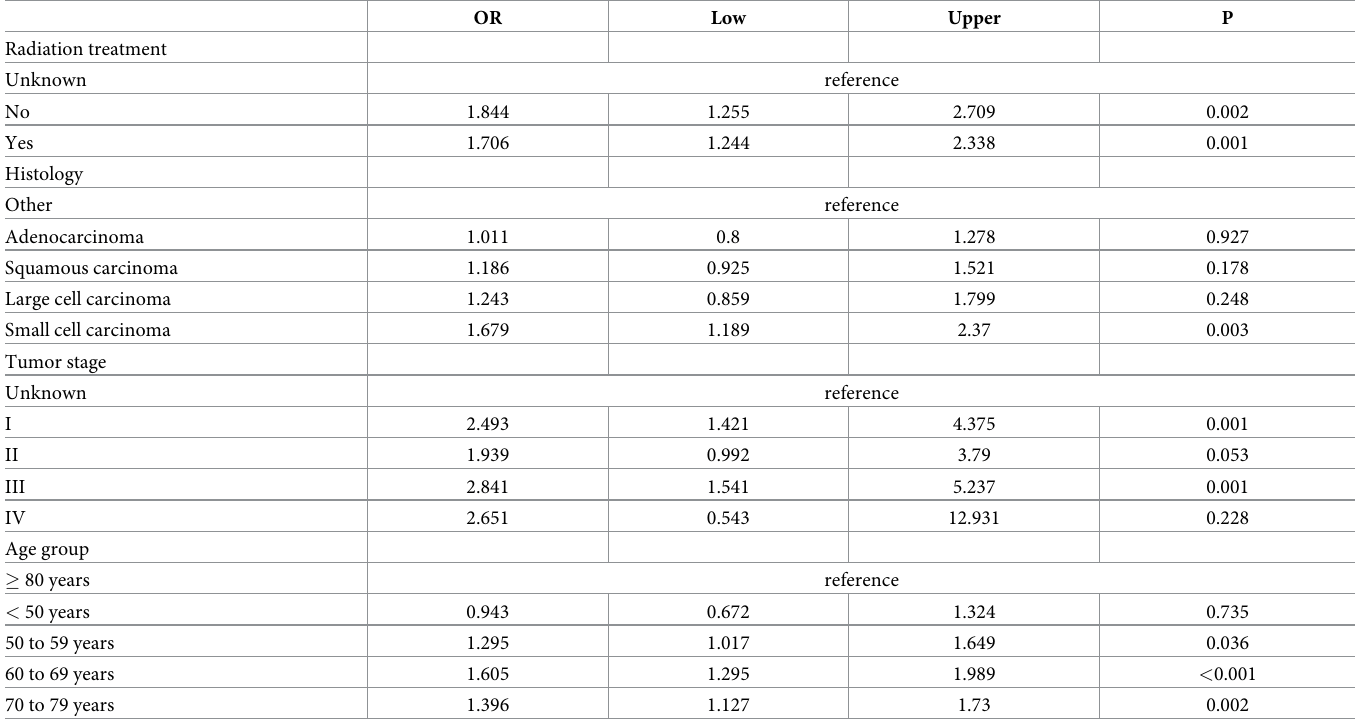
Table 3. Risk factors of metachronous second primary lung cancer in the final risk prediction nomogram.